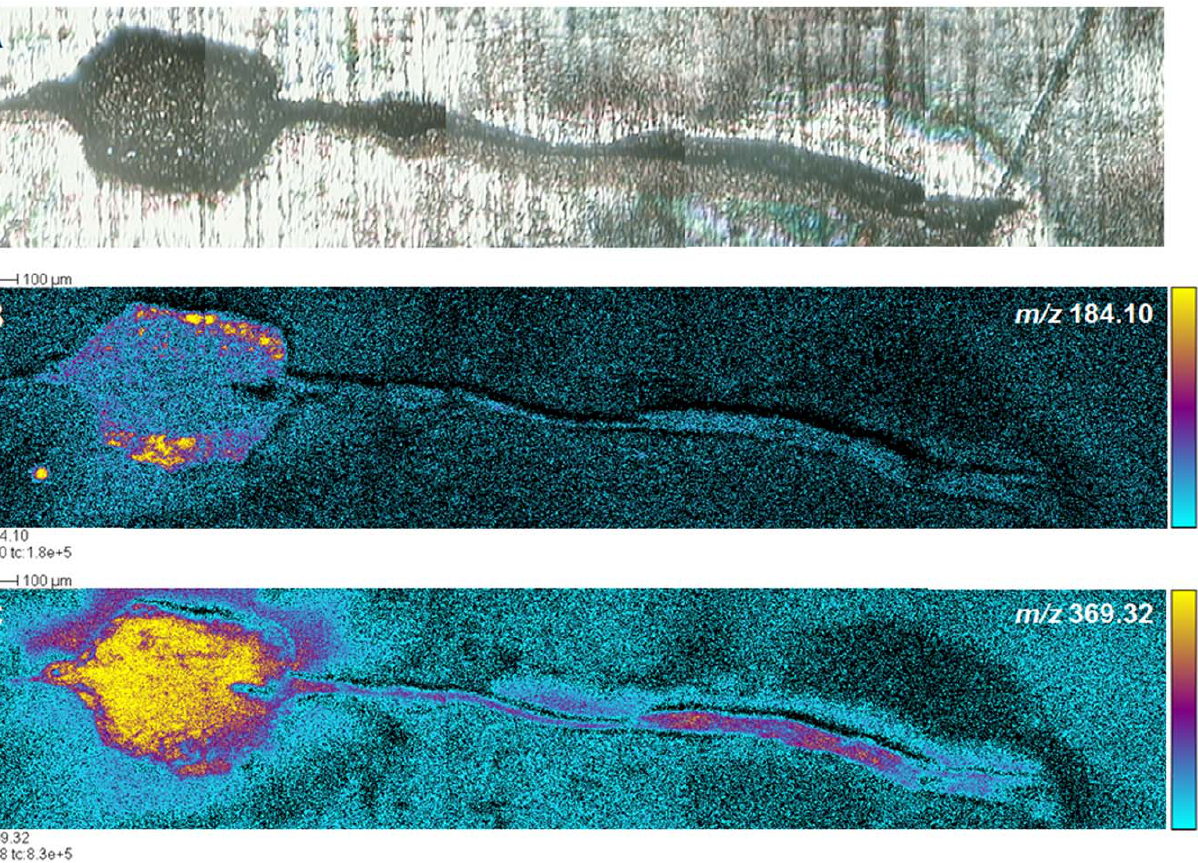
Figure 5. ToF-SIMS analysis of lipids in a portion of control leech nerve cord, including a ganglion. A . Optical, transmitted light low- resolution image of unstained tissue (ganglion and parts of attached nerve) prior to ToF-SIMS analyses. The ganglion is placed in gelatin before being sectioned at 10 m m. The slices are deposited onto silicium target. B, C . Tissue distributions of two ions, m/z 184.1 and m/z 369.32, corresponding to the phosphocholine ion and to the cholesterol fragment ion [M + H-H 2 O] + , respectively. The phosphocholine ion can be observed mainly in the outer areas of the ganglion, where neuronal somata and glial packets are located, while the cholesterol fragment ion is also found throughout the central neuropil. Five adjacent individual images of 500 6 500 m m 2 where assembled end-to-end to create these images. Color scale bars, with amplitude in number of counts, are indicated to the right of each ion image. The amplitude of the color scale corresponds to the maximum number of counts mc and could be read as [0, mc ]. tc is the total number of counts recorded for the specified m/z (sum of counts in all the pixels).